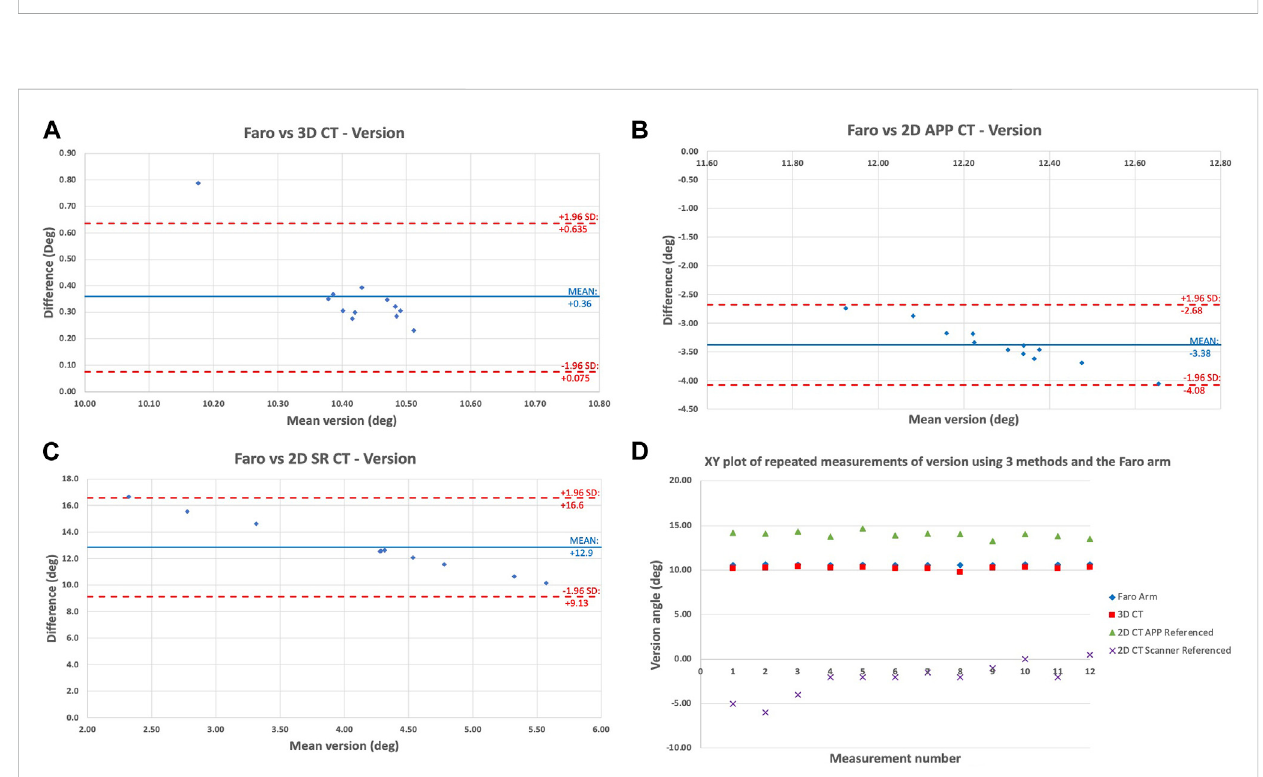
FIGURE 2 Bland-Altman plot showing the level of agreement/disagreement between the digitising arm inclination measurements and (A) 3D APP CT; (B) 2D APPCT; (C) 2DSRCT; (D) XYscatterplotofthe12repeatedmeasurementsofinclinationanglesaccordingtoeachofthe3imagingmethodsandtheFaro digitising arm for pelvis 1A by observer 1.